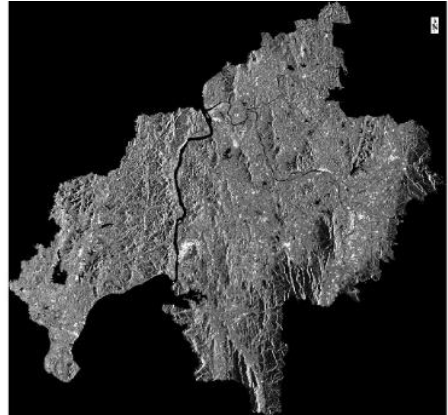
Figure 3. The homogeneity of the gray-level co-occurrence matrix